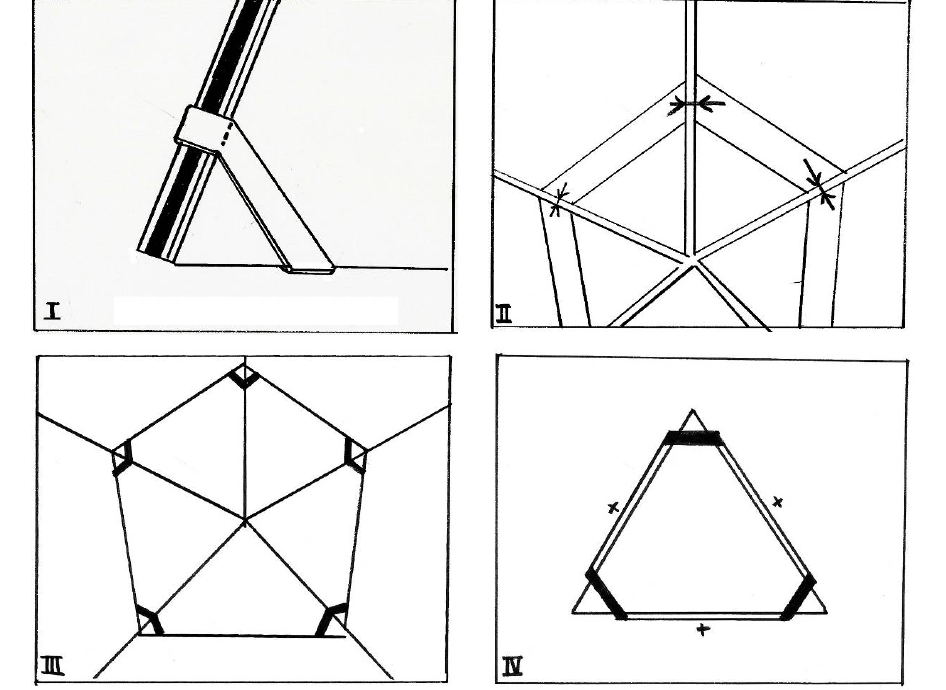
Figure 6: Steps of development of socket